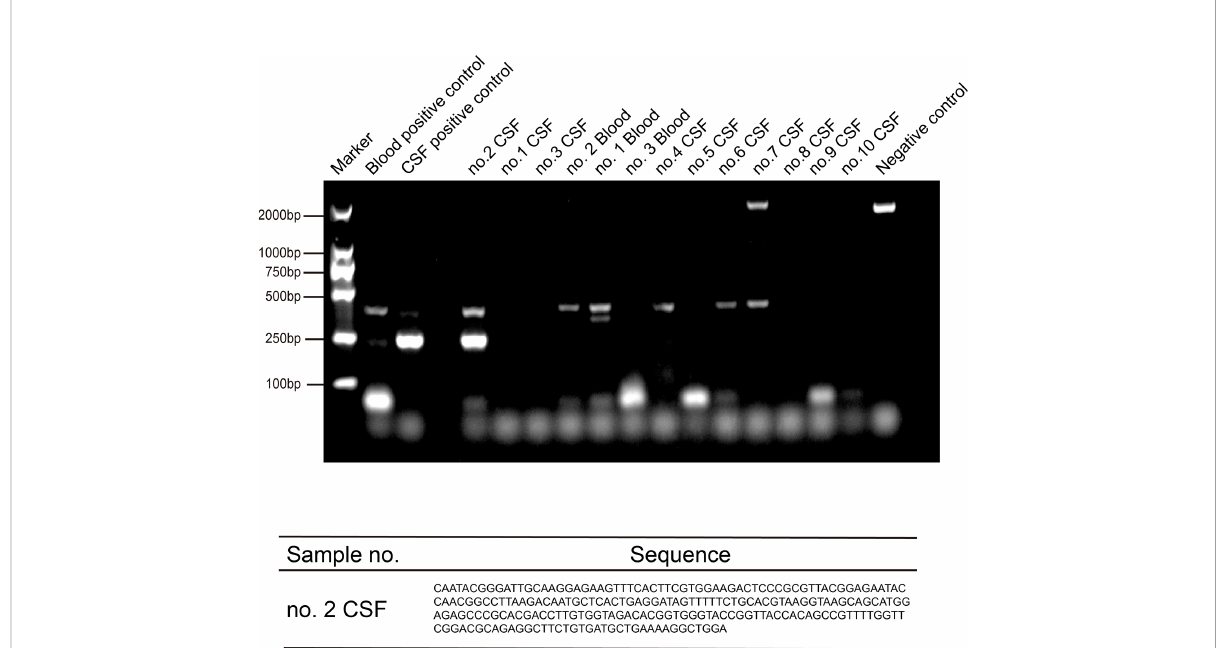
FIGURE 3 PCR and sequencing ampli fi cation of Treponema pallidum by TpN47 were followed by agarose gel electrophoresis to con fi rm Treponema pallidum sequences for three positive blood and 10 cerebrospinal fl uid (CSF) samples. The blood positive control was from one patient ’ s blood sample (toluidine red unheated serum test [TRUST] titer was 1:256); the CSF positive control was from one patient ’ s CSF sample (positive serologic assays and metagenomic next-generation sequencing (mNGS); and the negative control was blank without